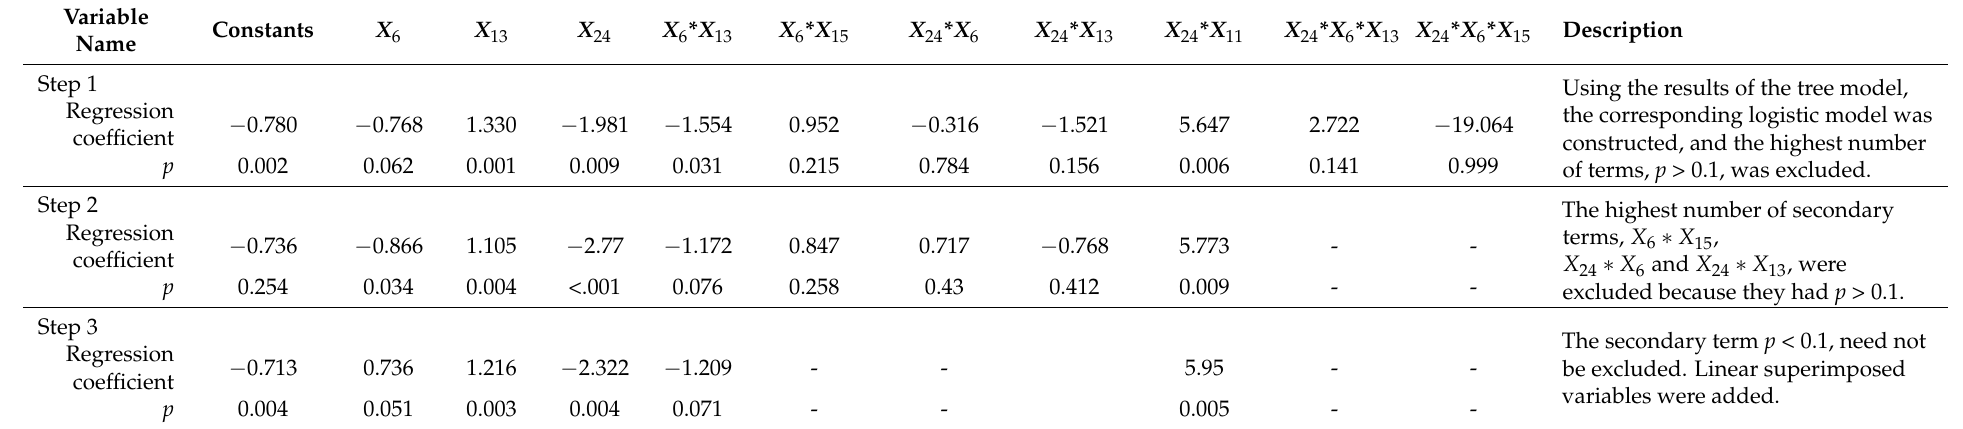
Table 3. Test interaction terms with logistic models on the results of decision trees.